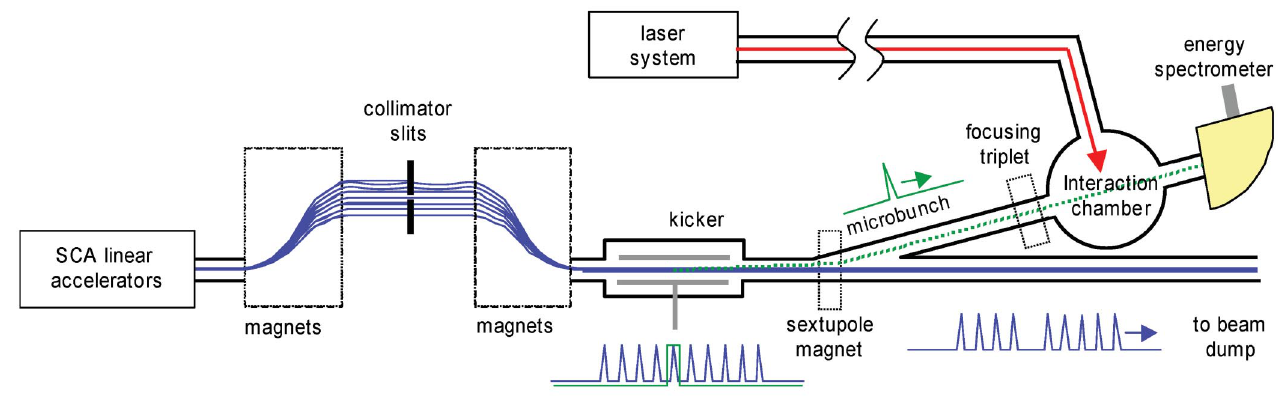
FIG. 5. (Color) Diagram of the electron beam line at the SCA-FEL